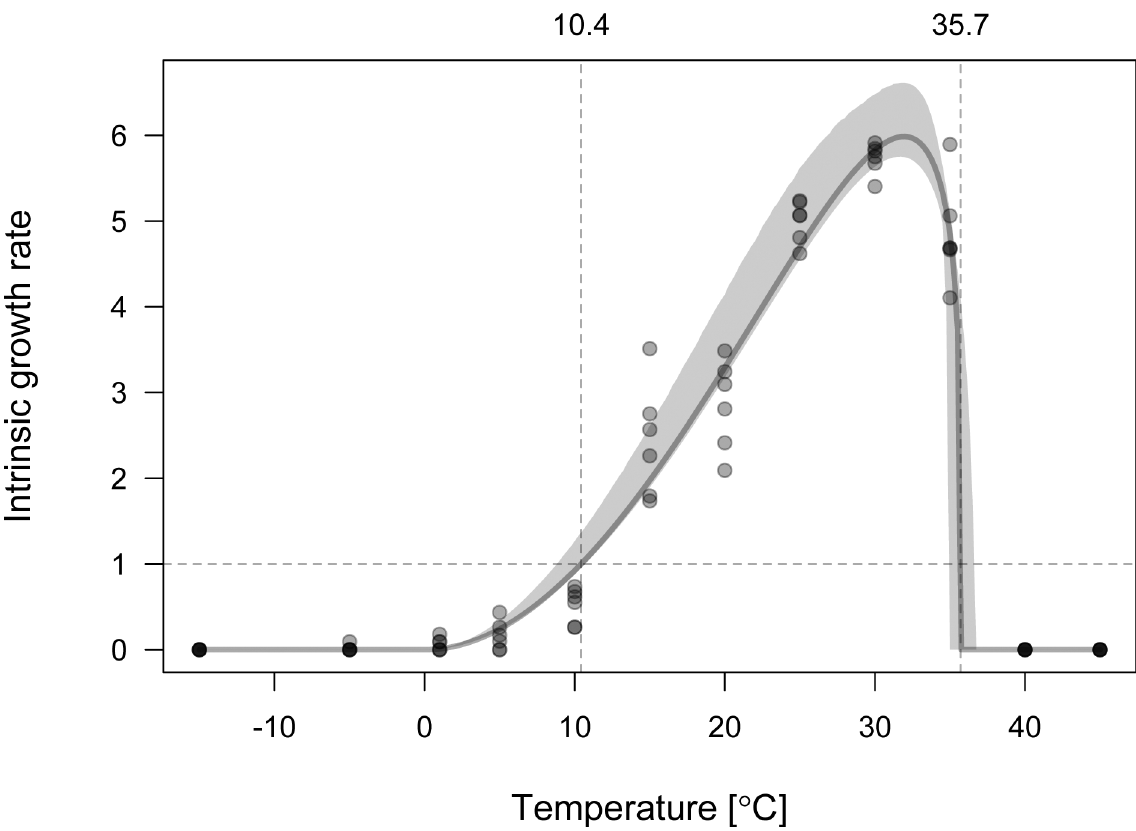
Fig 3. Relationship between the temperature and population growth rate for Aceria tosichella lineage MT-8. Vertical lines denote temperature ranges within which the population increases in numbers. Shaded region represents standard error band.